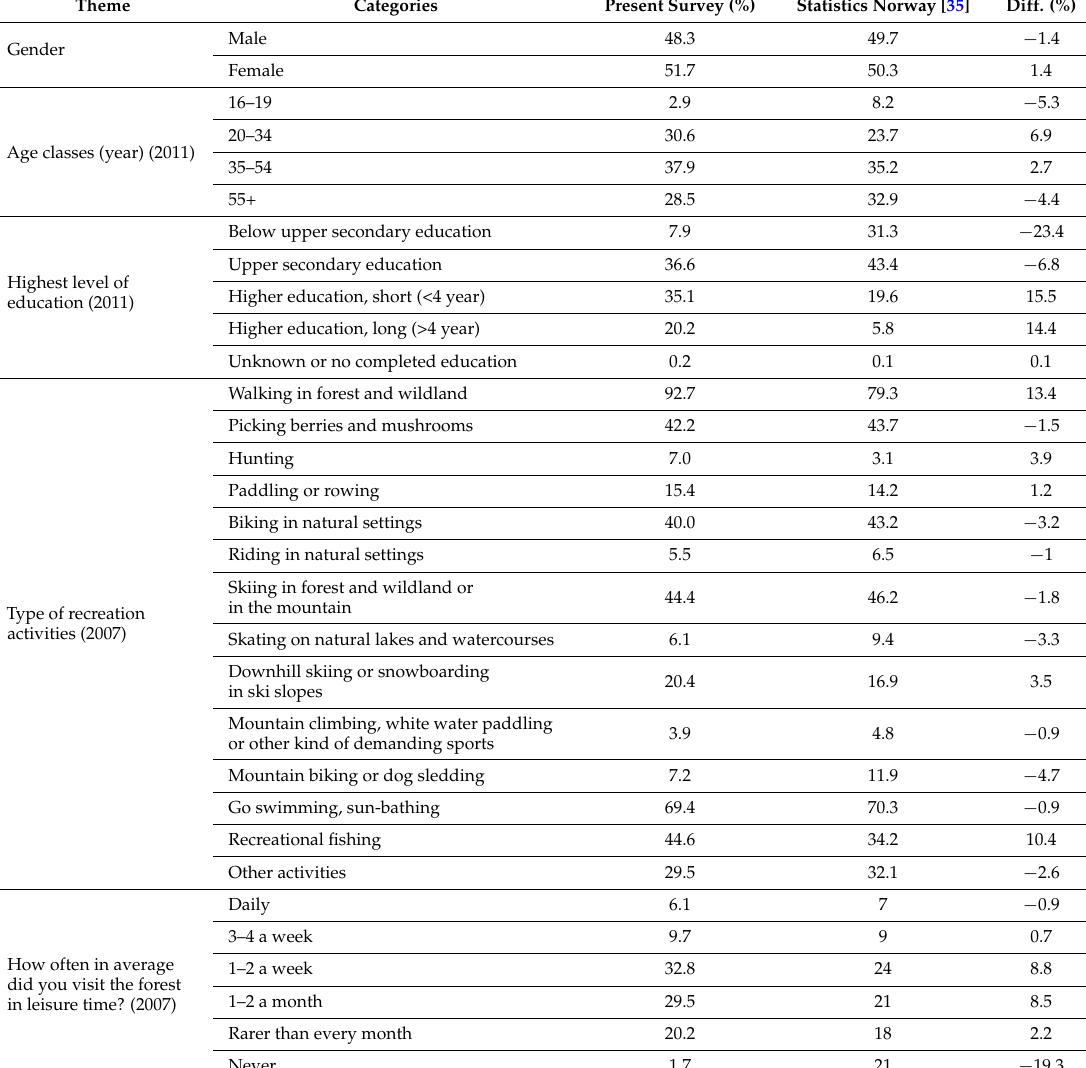
Table 3. The representativity of the survey population ( n = 545). Percentages of present survey sample compared with the national